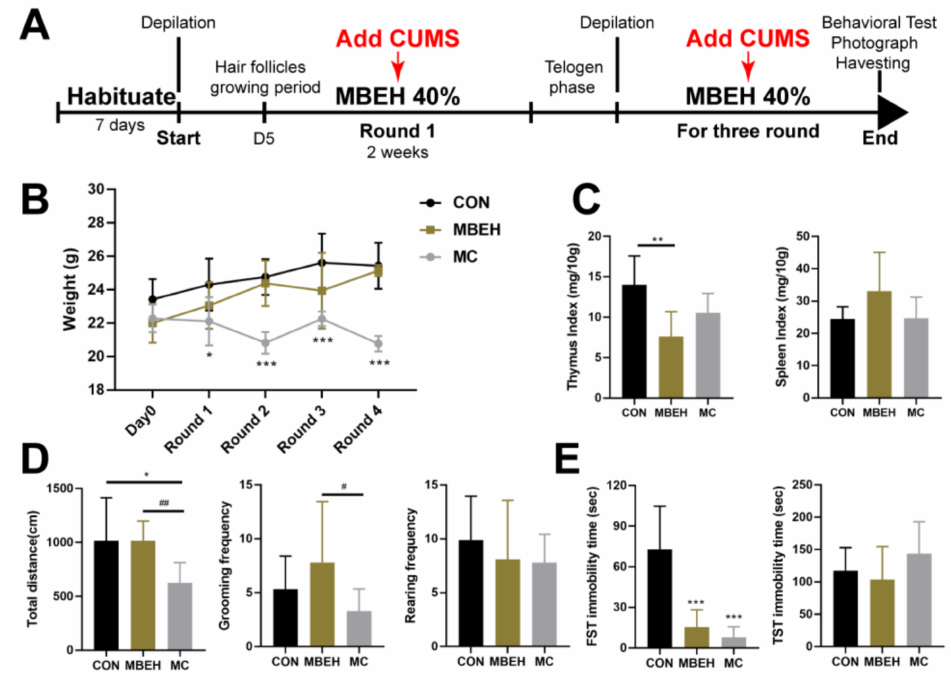
Figure 2. Mice in the MC group exhibit depression-like behavior (n = 9). ( A ) The flowchart of MBEH and MC modeling. ( B ) Effects of MBEH and MC on body weight. ( C ) The effects of MBEH and MC on the thymus index and spleen index. ( D , E ) The effect of MBEH and MC on spontaneous activity and behavioral despair in mice. Data were presented as the mean ± SD. * p < 0.05, ** p < 0.01, *** p < 0.001, compared with CON; # p < 0.05, ## p < 0.01, MC was compared with MBEH. Multiple groups were tested using one-way